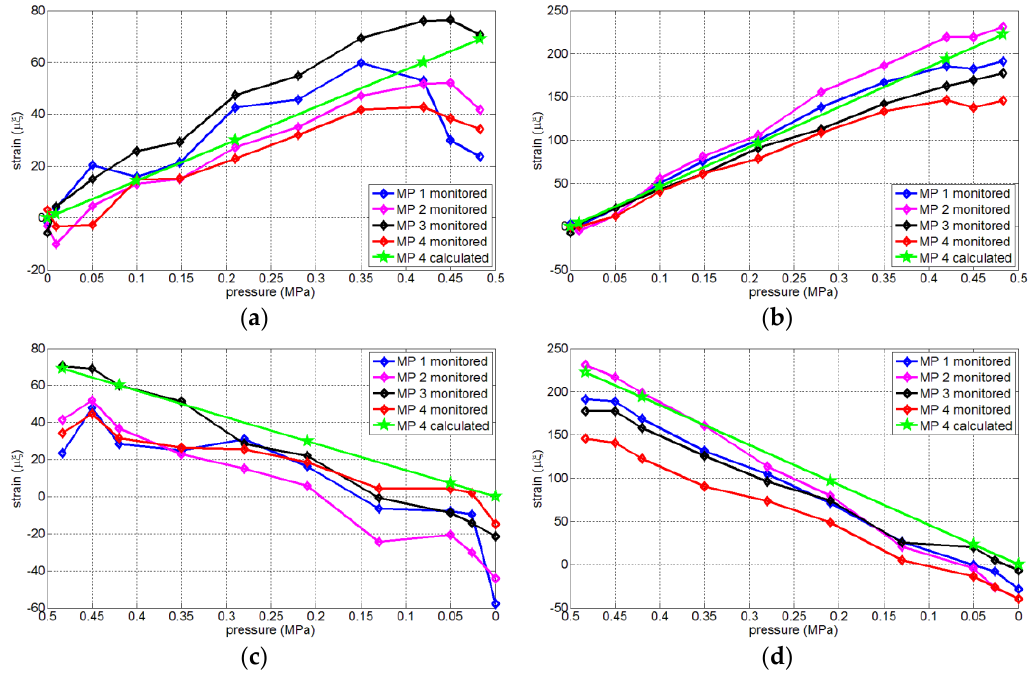
Figure 14. Concrete strain-inner pressure relationship. ( a ) Vertical direction during pressurization; ( b ) Circumferential direction during pressurization; ( c ) Vertical direction during depressurization; ( d ) Circumferential direction during depressurization.